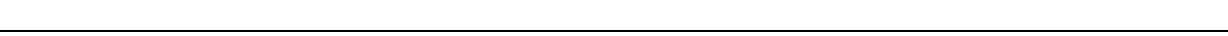
mutually exclusive (Supplementary Fig. 2h; P o 2.2 (cid:2) 10 (cid:3) 16 by w 2 -test).